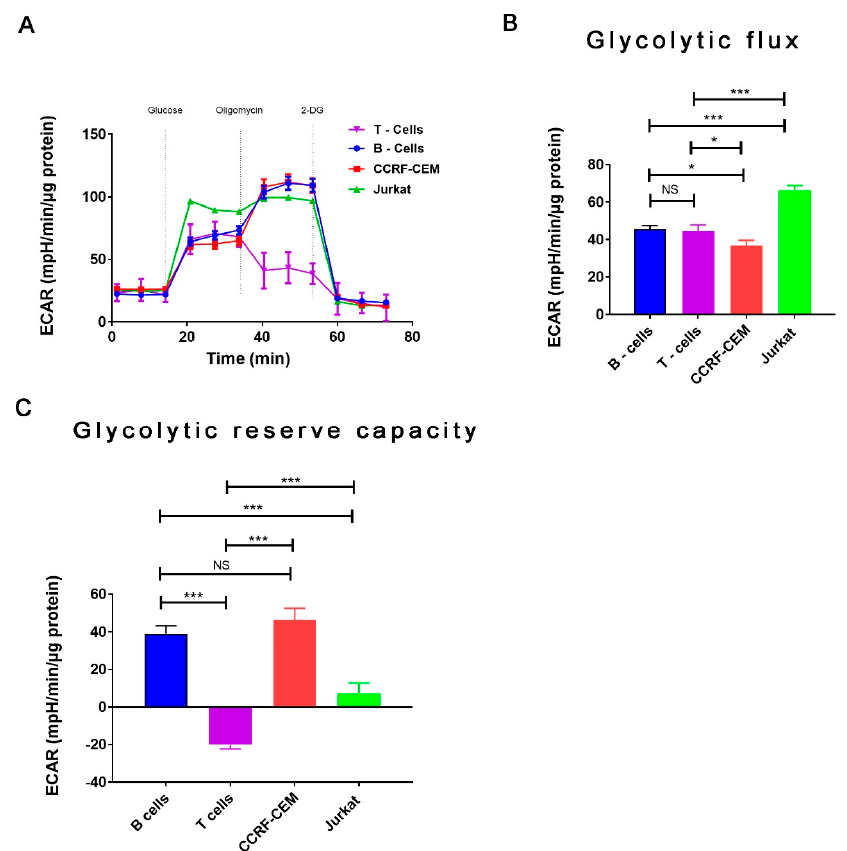
Figure 2. Glycolytic function characterization in normal lymphocytes and T-ALL cell lines. ( A ). Extracellular acidification rate (ECAR) in T-cells (purple), B-cells (blue), CCRF-CEM (red), and Jurkat cells (green) exposed sequentially to 10 mM glucose, 1 µM oligomycin, and 100 mM 2-deoxygucose (2-DG). ( B ). Glycolytic flux rate of T-cells (purple), B-cells (blue), CCRF-CEM (red), and Jurkat cells (green) calculated as the mean acidification rate after glucose injection minus the non- glycolytic acidification rate. n = 6, mean ± S.E., * p < 0.05, *** p < 0.001, NS = not significant ( t -test). ( C ). Glycolytic reserve capacity of T-cells (purple), B-cells (blue), CCRF-CEM (red), and Jurkat cells (green) calculated as the mean acidification rate measured after oligomycin injection minus the mean acidification rate measured after glucose injection. n = 6, mean ± S.E., * p < 0.05, *** p < 0.001, NS = not significant ( t -test).